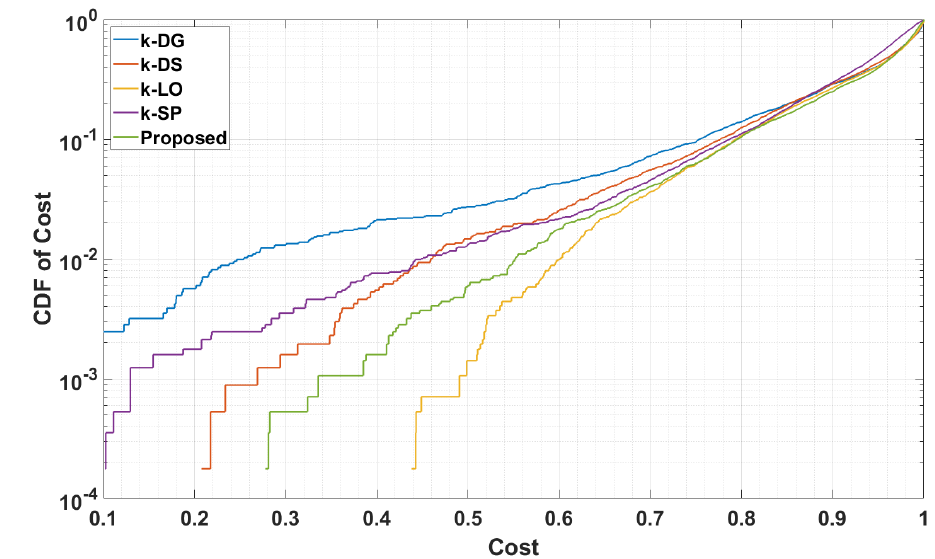
Figure 3. CDF of the attackers’ costs of launching DDoS Attack on an LEO satellite